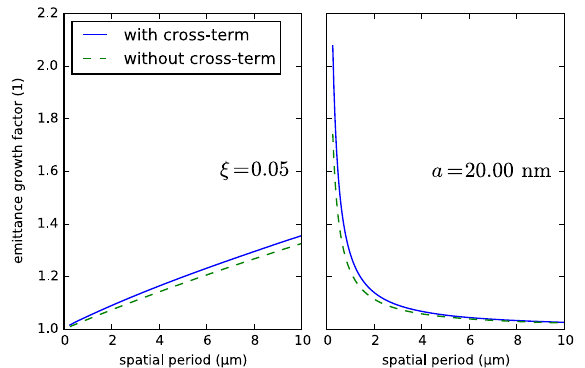
FIG. 5. Emittance growth factor vs spatial period for a 2D sinusoidal surface. The applied field strength is 50 MV = m. The subplot on the left: Keep aspect (amplitude over spatial period) of the pattern on the surface as a constant ( ξ ¼ 0 . 05 ). The subplot on the right: Keep the amplitude of the surface as a constant ( a ¼ 20 . 00 nm).